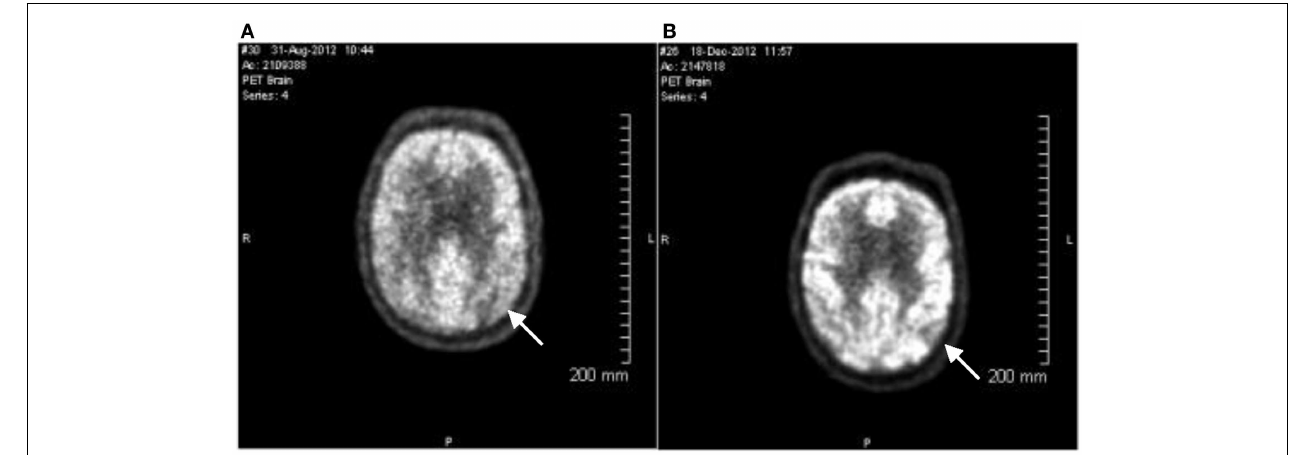
parietal lobe. (B) Image taken December 18th, 2012. Findings are stable from the prior exam. Arrow indicates relative hypometabolism of right lateral parietal lobe.The pattern of hypometabolism involving the parietal and temporal lobes is stable and is consistent with the clinical diagnosis of probable Alzheimer’s